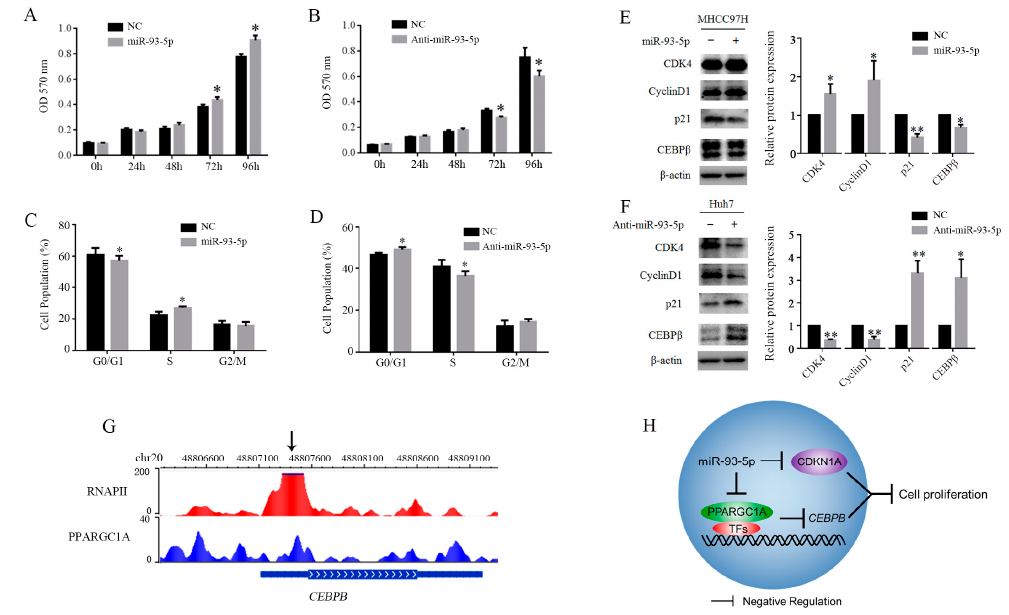
Figure 5. MiR-93-5p promotes hepatoma cells proliferation. ( A , B ) MTT assays were preformed to show the effect of miR-93-5p on hepatoma cells; ( C , D ) Flow cytometry assays were preformed to analyze hepatoma cells cell-cycle distribution; ( E , F ) Western blot analysis of protein levels of CDK4, CyclinD1, p21, and CEBP β upon treatment with miR-93-5p or anti-miR-93-5p for 48 h; ( G ) Binding sites of PPARGC1A and RNAPII at the promoter regions of CEBPB gene. x -axis represents chromosomal positions; ( H ) Schematic representation of regulatory pathway from miR-93-5p to cells proliferation. MTT: methylthiazolyldiphenyl-tetrazolium bromide; CDK4: cyclin dependent kinase 4; CEBPB: CCAAT/Enhancer binding protein beta; RNAPII: RNA polymerase II.